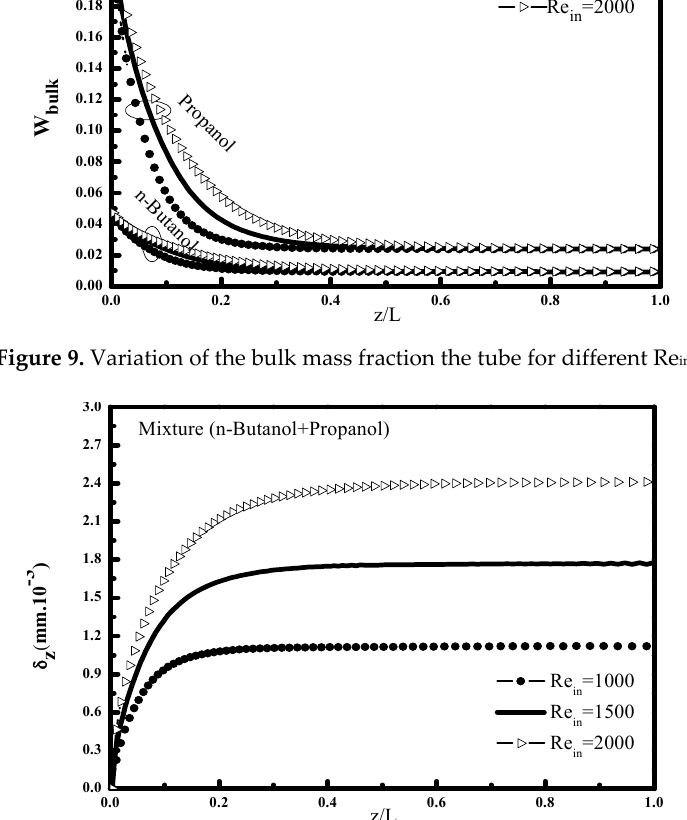
Figure 10. Variation of the liquid film thickness for different Re in